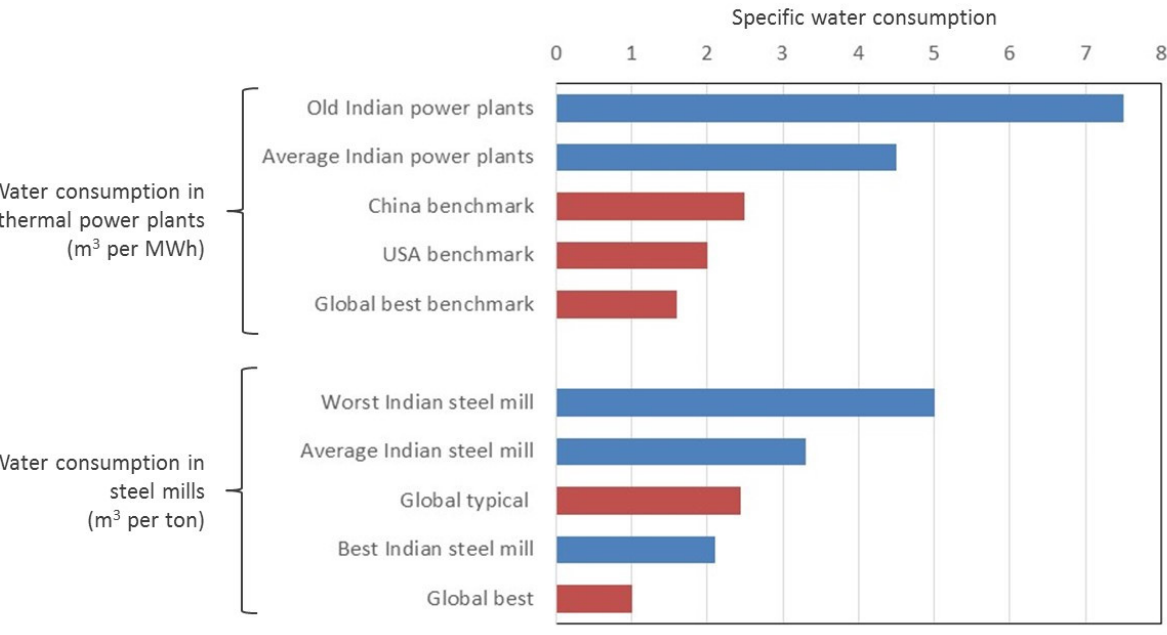
and Indian steel mills ( bottom ), compared to international